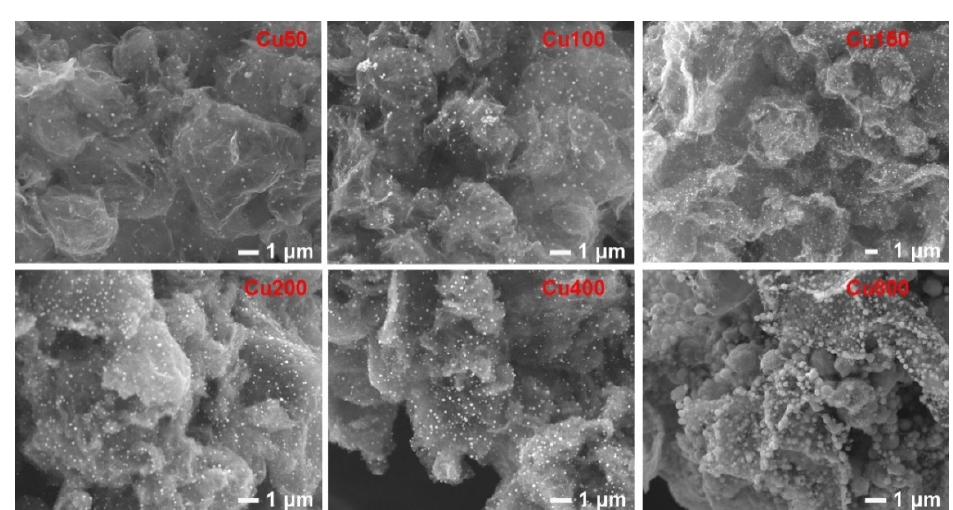
Figure 2. The SEM images for different Cux catalysts after reduction.